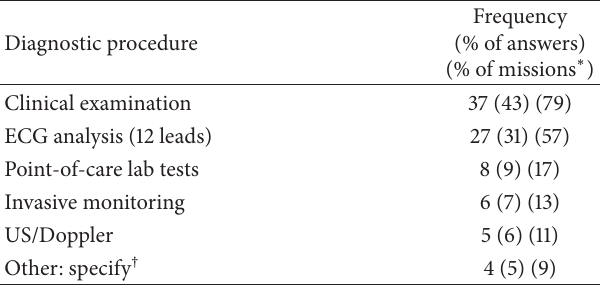
Table 6: Diagnostic procedure performed by HEMS during the study’s